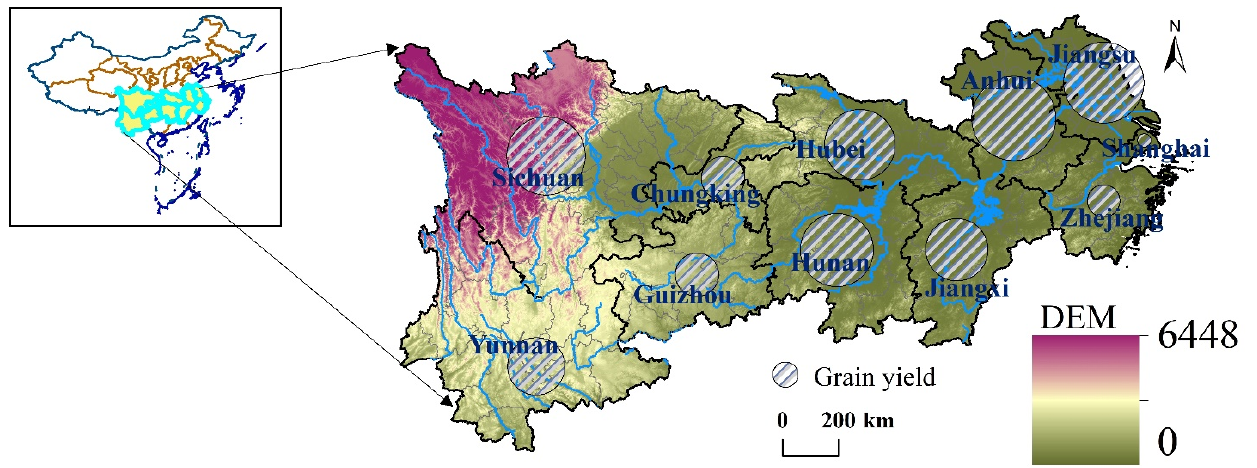
Figure 1. Spatial distribution characteristics of DEM in the Yangtze River basin. Notes: Grain yield refers to the total amount of grain produced in the calendar year of agricultural producers and operators. Grain yield is categorized by harvest season, including summer harvest, early rice, and autumn harvest; and by crop variety, including cereals, potatoes, and legumes.